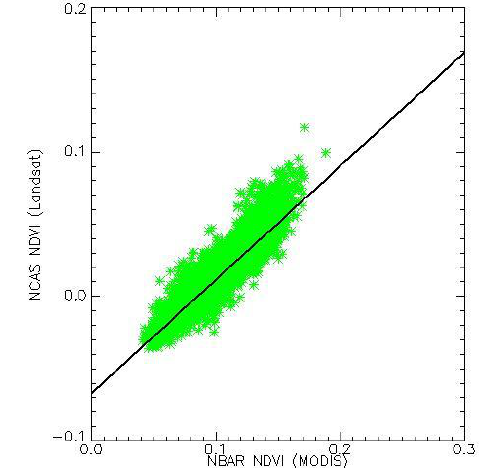
Figure 9. NCAS Landsat NDVI (y-axis) is plotted against MODIS NBAR NDVI (x-axis) for the study area. A line of best fit between the two variables is also plotted.